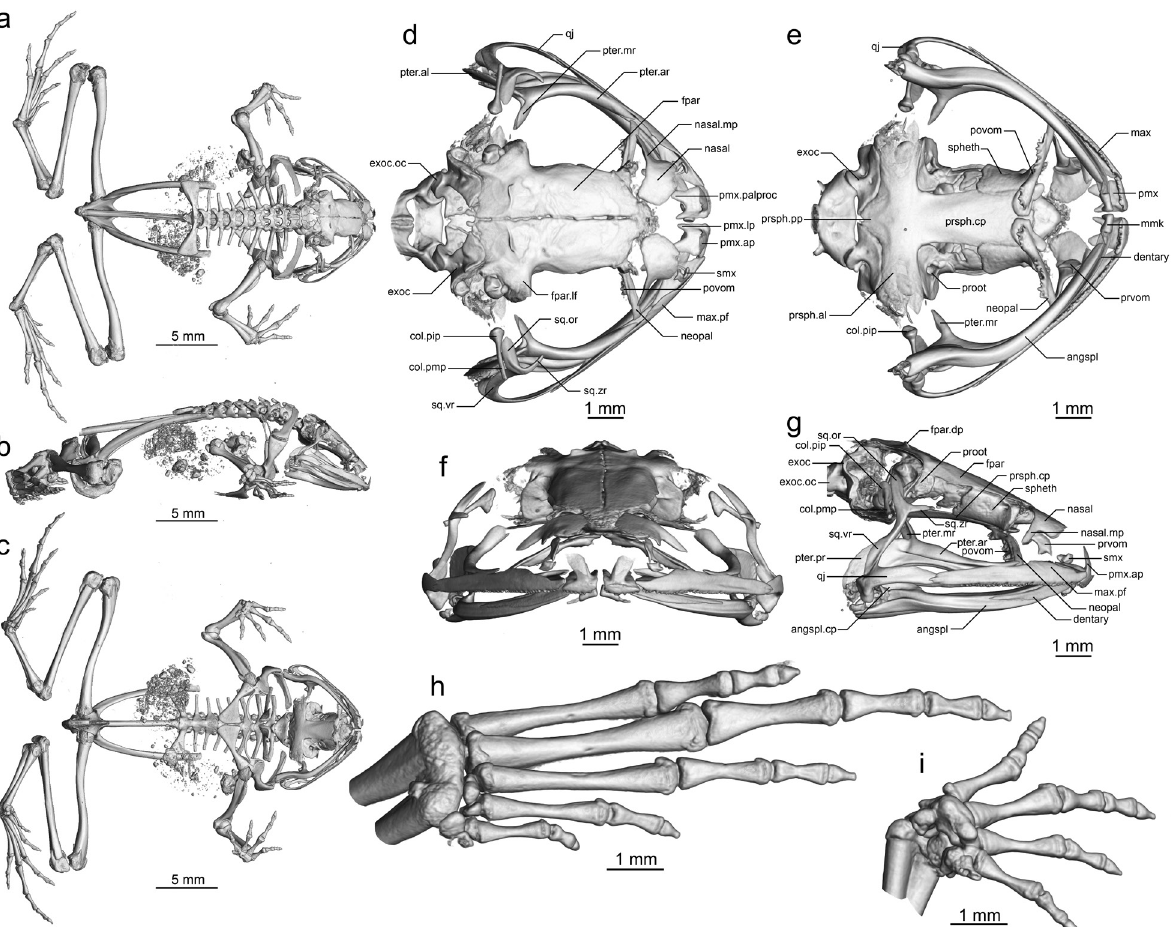
Figure 3. Volumetric renderings of micro-CT scans of the skeleton of the holotype of Rhombophryne ellae sp. nov. (ZSM 76/2018). a–c. Full skeleton in ( a ) dorsal, ( b ) lateral, and ( c ) ventral view; d–g. Skull in ( d ) dorsal, ( e ) ventral, ( f ) anterior, and ( g ) lateral view; h. Foot in ventral view; i. Hand in ventral view. Abbreviations: angspl – angulosplenial; angspl.cp – coronoid process of the